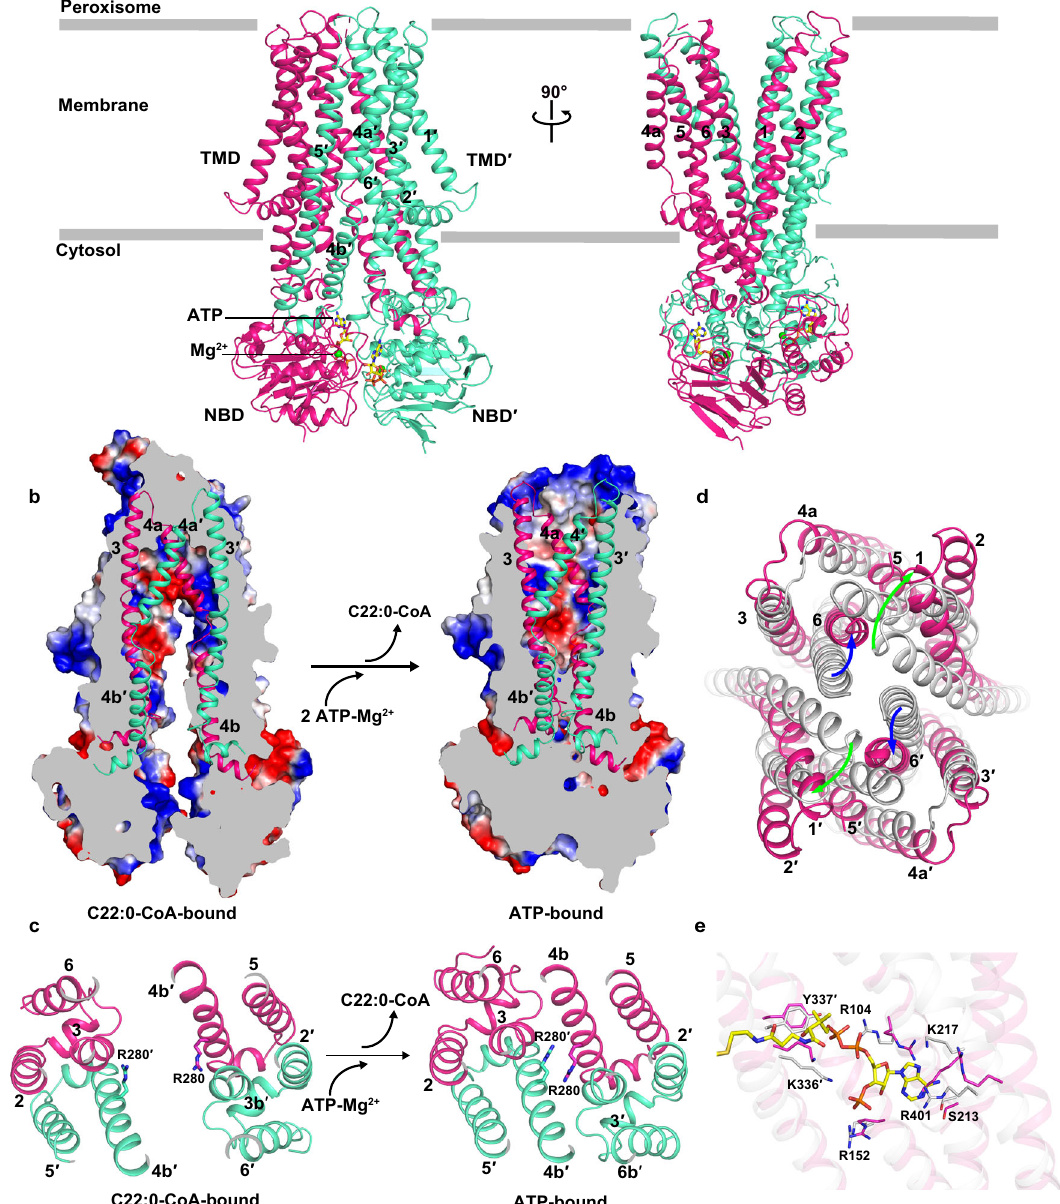
Fig. 4 Structure of ATP-bound ABCD1 and comparison with the C22:0-CoA-bound structure. a Cartoon representation of ATP-bound ABCD1. Two subunits of ABCD1 are colored in green and rose, respectively. ATP molecules are shown as yellow sticks, and Mg 2 + ions are displayed as green spheres. The number of TMs are labeled. Conformational changes upon ATP binding accompanied with substrate release, as shown by b cutaway representation of the electrostatic surface, and c top view of C22:0-CoA-bound-ABCD1 and ATP-bound-ABCD1. TM3/TM3 ′ and TM4/TM4 ′ are shown as cartoon. The electrostatic surface was generated by PyMOL 2.5.2. The residue Arg280 is shown as sticks. Superposition of ( d ) the TMDs and ( e ) the CoA portion binding pocket of C22:0-CoA-bound ABCD1 (gray) against the ATP-bound form (rose). TM helices are shown as cartoons and numbered. The shifts of TM1/TM1 ′ and TM6/TM6 ′ are indicated in green or blue arrows, respectively. The residues interacting with CoA portion of C22:0-CoA are displayed as